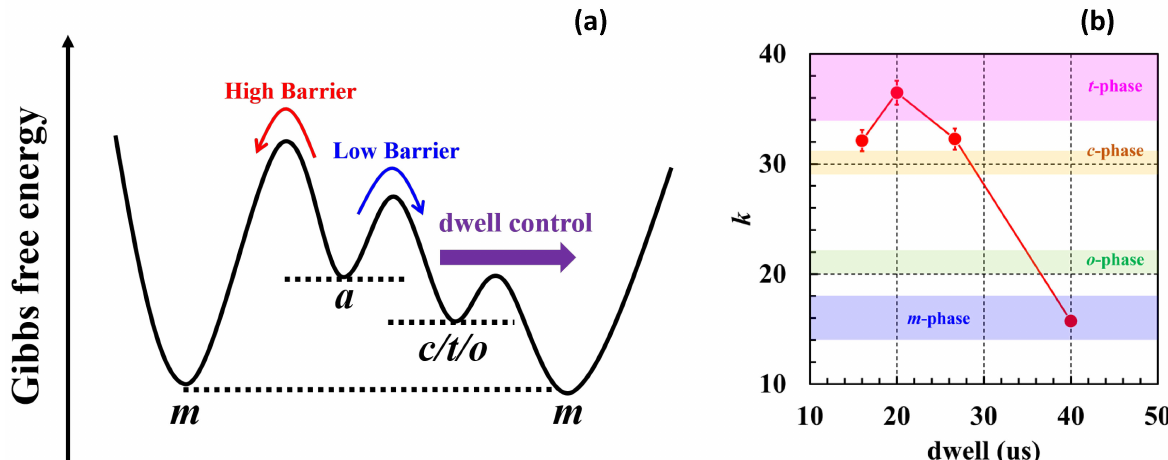
Figure 19. ( a ) Schematic Gibbs free energy diagram of different HfO 2 crystal phases, where the character “ a ” stands for the amorphous state, “ c ” for the c -phase, “ t ” for the t -phase, “ o ” for the o -phase, and “ m ” for the m -phase, respectively. ( b ) Relative permittivity ( k ) values of the 10 nm thick HfO 2 films as a function of the UV-LA dwell time. The theoretically predicted k -value range of each phase is shown together. Reprinted/adjusted with permission from Ref. [102]. 2021, The Japan Society of Applied